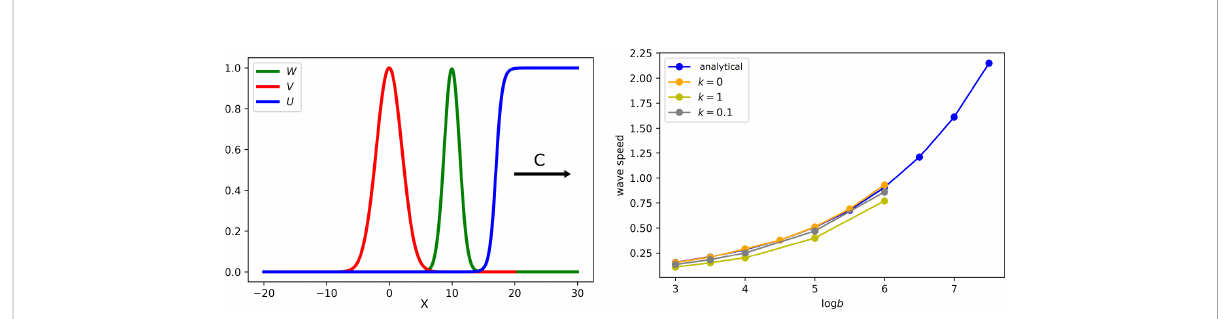
FIGURE 7 Left: snapshot of the solution of system (5.7) – (5.9). If the virus replication number R v is larger than 1, infection spreads as a reaction – diffusion wave with speed c . All curves are normalized to their maximum. Right: wave speed as a function of virus replication rate b for different rates of the clonal expansion of immune cells. Analytical value for k 1 = 0 is obtained by formula (5.14). Numerical values are found from the solution of system (5.1) – (5.6) (for a single virus) with the values of k 1 indicated in the fi gure. The values of parameters: a 1 = 0 : 1, k = 0, D = 0 : 001, s 1